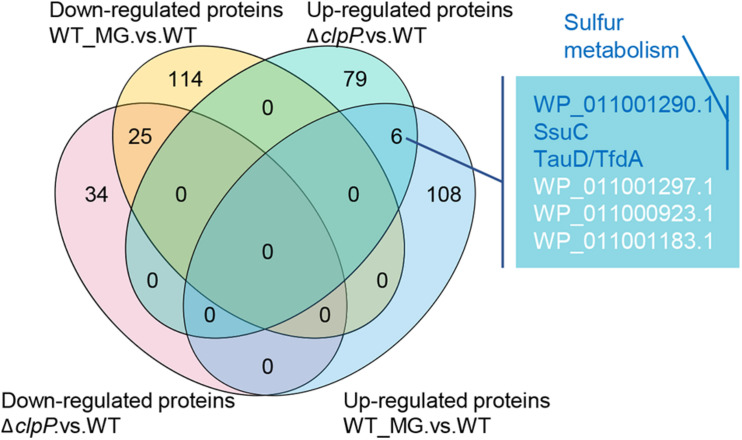
Differentially expressed proteins shared by ΔclpP versus wild-type (WT) and WT_MG versus WT.